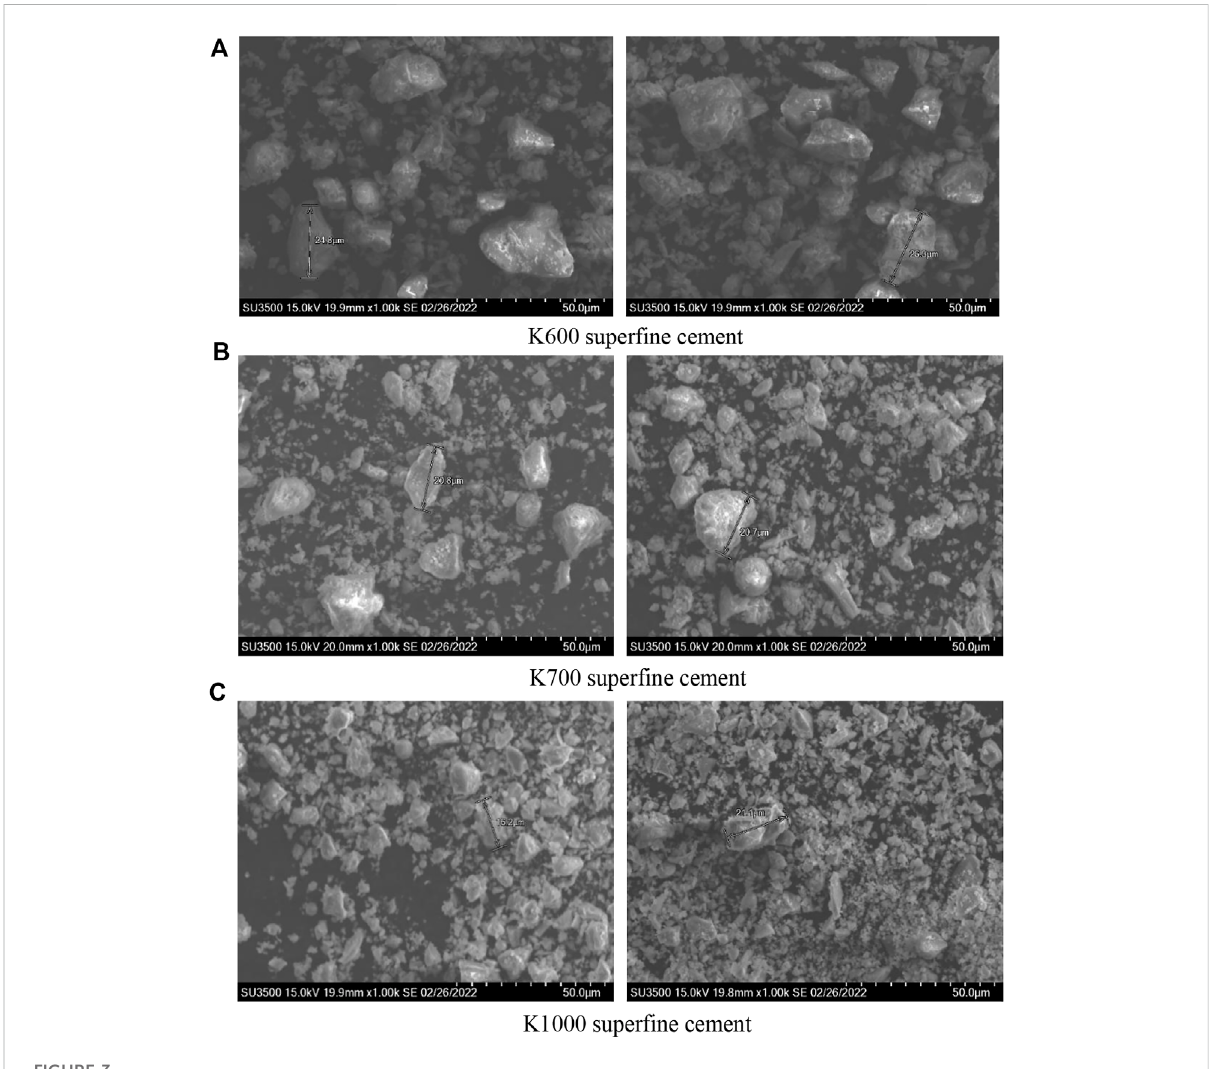
FIGURE 3 SEM of super fi ne cement